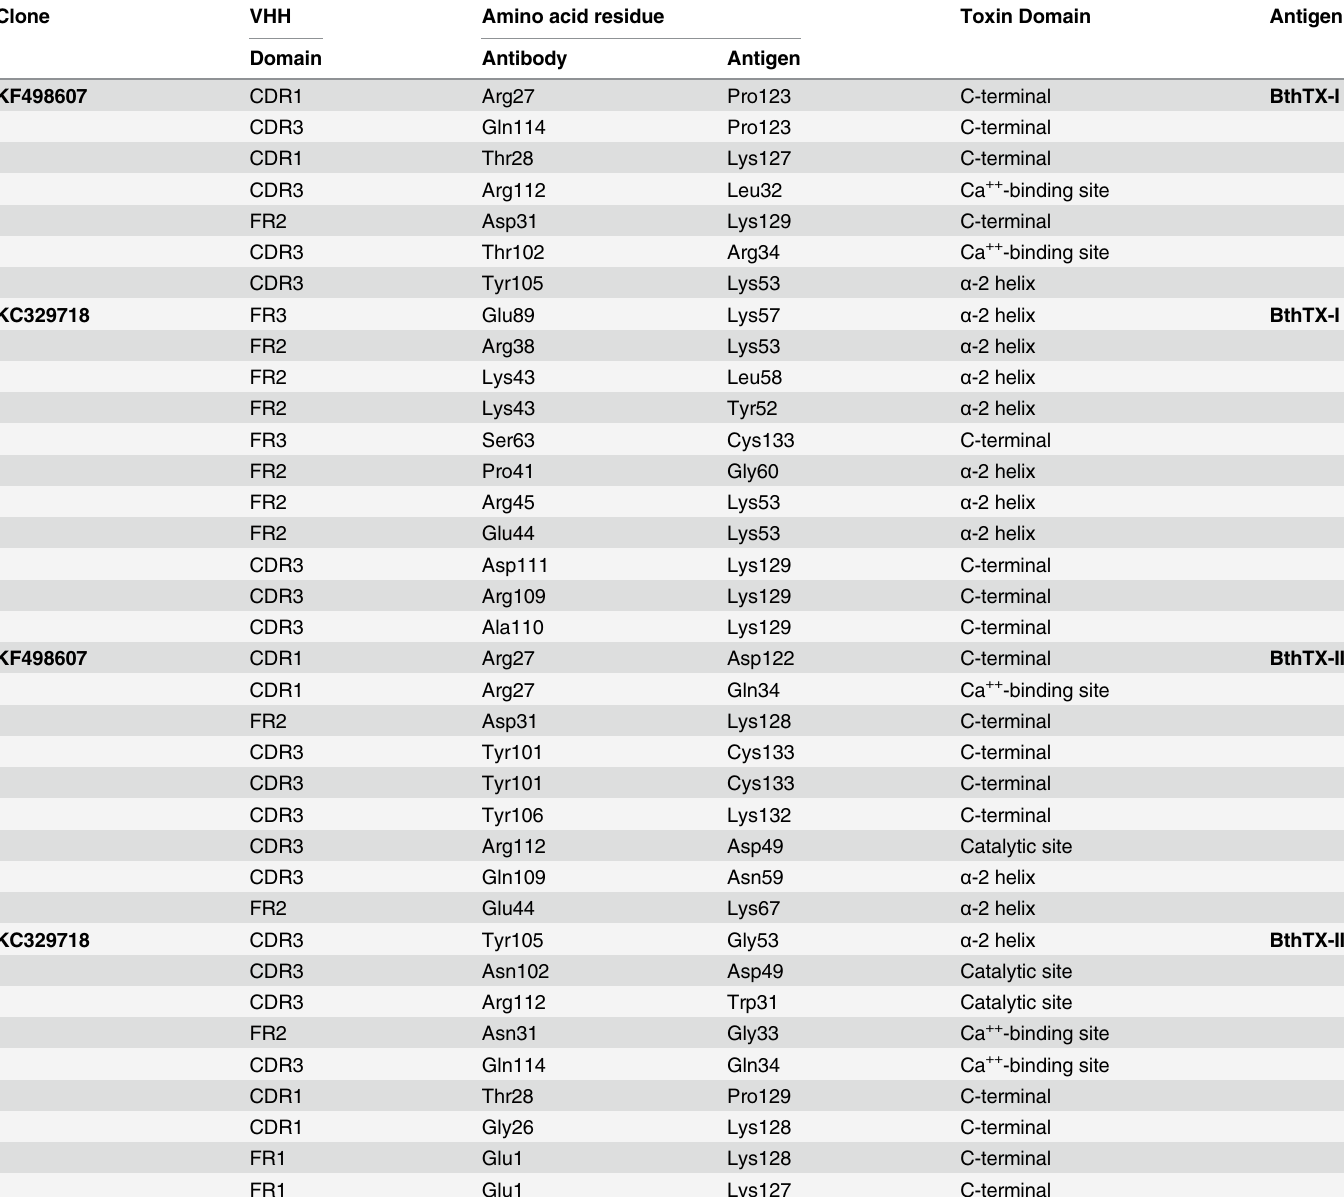
Table 4. Molecular interactions between the amino acid residues of VHHs and PLA 2